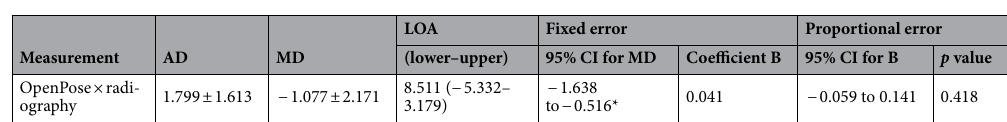
Table 3. Bland–Altman analysis between OpenPose and radiography. Values are presented as mean ± standard deviation. AD mean of absolute difference, MD mean of difference, LOA 95% limits of agreement, CI confidence intervals. *Indicates that there was a significant fixed